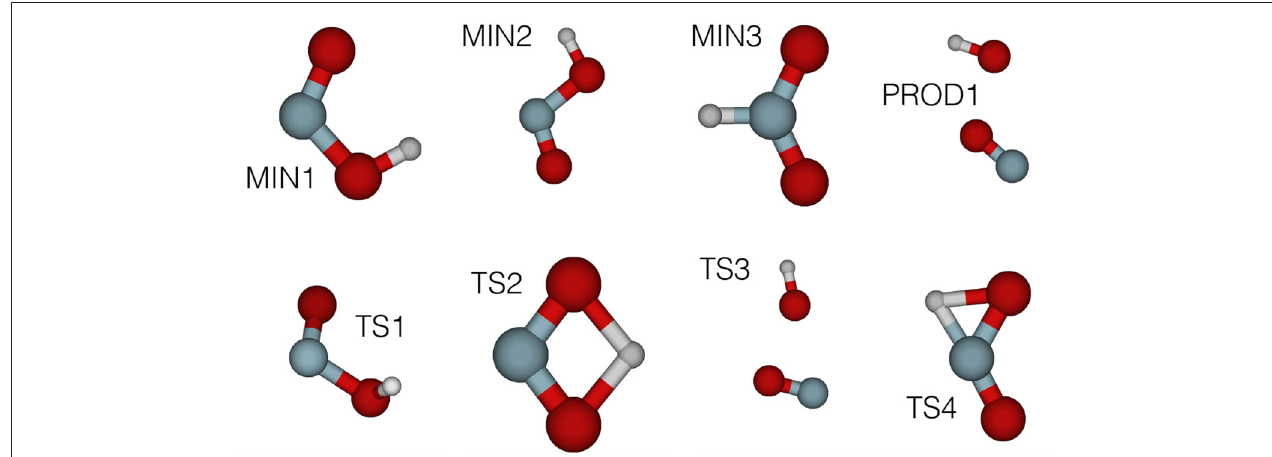
FIGURE 3 | MP2/cc-pVDZ (intermediate HL) structures of HONO automatically obtained using the TSSCDS algorithm on a PM7 (LL) PES. Target geometries in the cis-trans isomerization region (MIN1, MIN2, TS1) were subsequently reoptimized at the CCSD(T)/cc-pVQZ (final HL) level of theory.